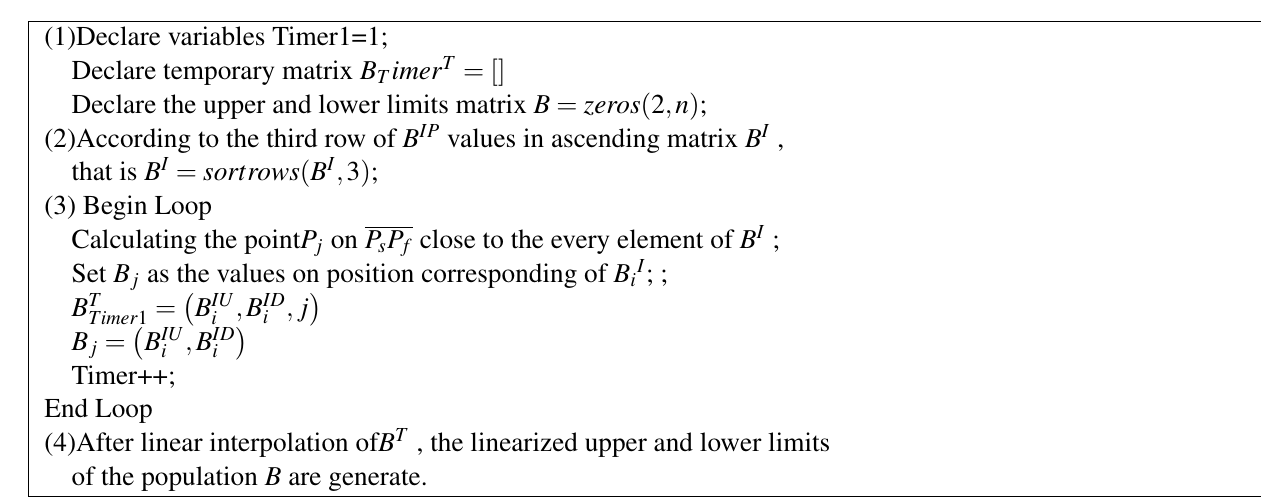
Fig. 6 Calculation of B